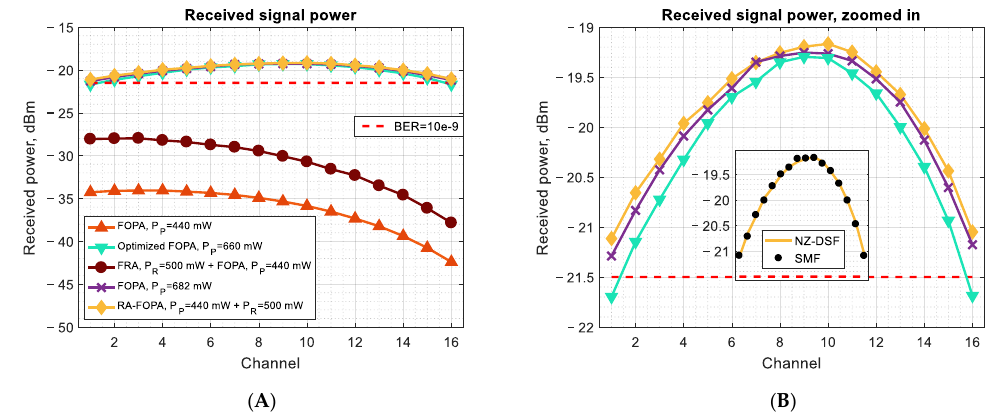
Figure 4. ( A ) Received signal power distribution of all 16 WDM channels in the case of RA-FOPA and FOPA combinations. Signal power obtained as the sum of the individual Fiber Raman amplifier (FRA) and FOPA gain is also shown. ( B ) Zoomed in view of ( A ) only showing the RA-FOPA, FOPA, and optimized FOPA. Inset in ( B ) shows similarities in received power when using SMF and NZ-DSF fibers for